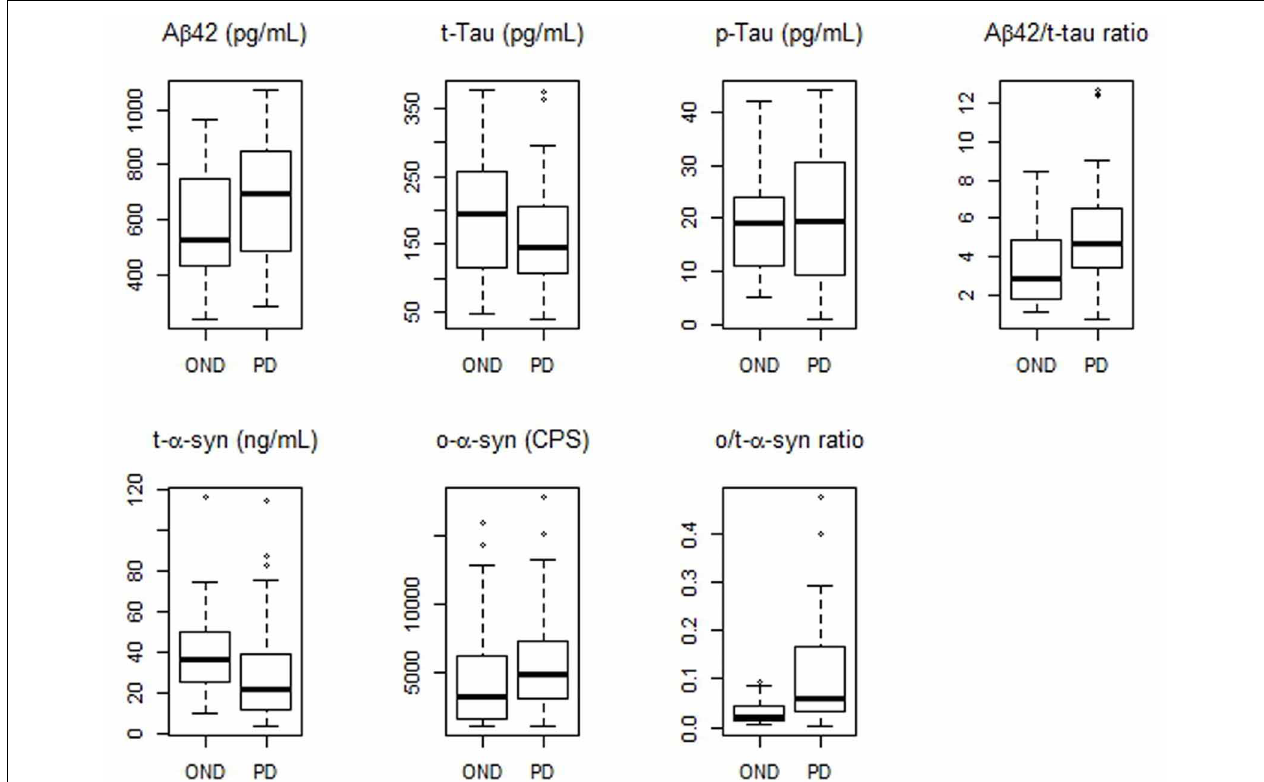
FIGURE 1 | Boxplots of CSF biomarkers values observed in PD and OND cohorts. The horizontal bold lines indicate the medians; the lower part of boxes indicates the first quartile and the upper part the third quartile; the dashed vertical lines indicate the range of values.